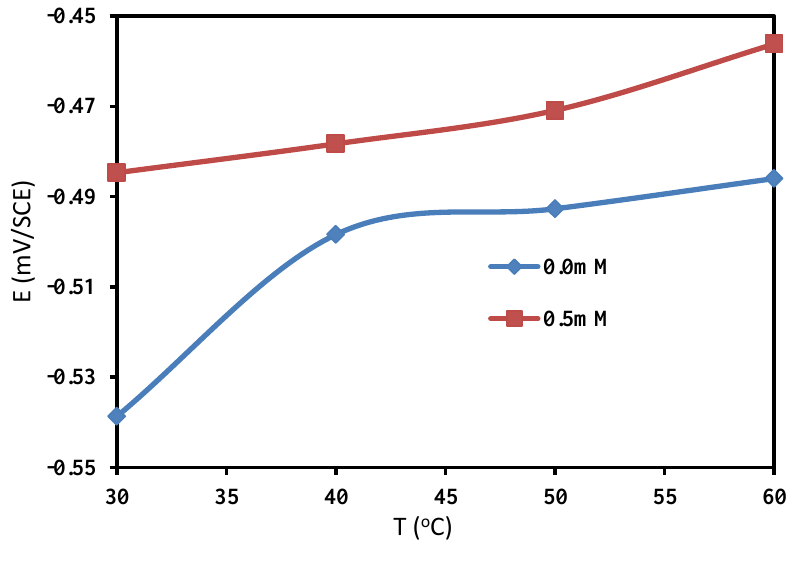
Figure 3. The change in OCP as a function of temperature for mild steel in 1.0 M HCl in the absence and presence of 0.5 mM